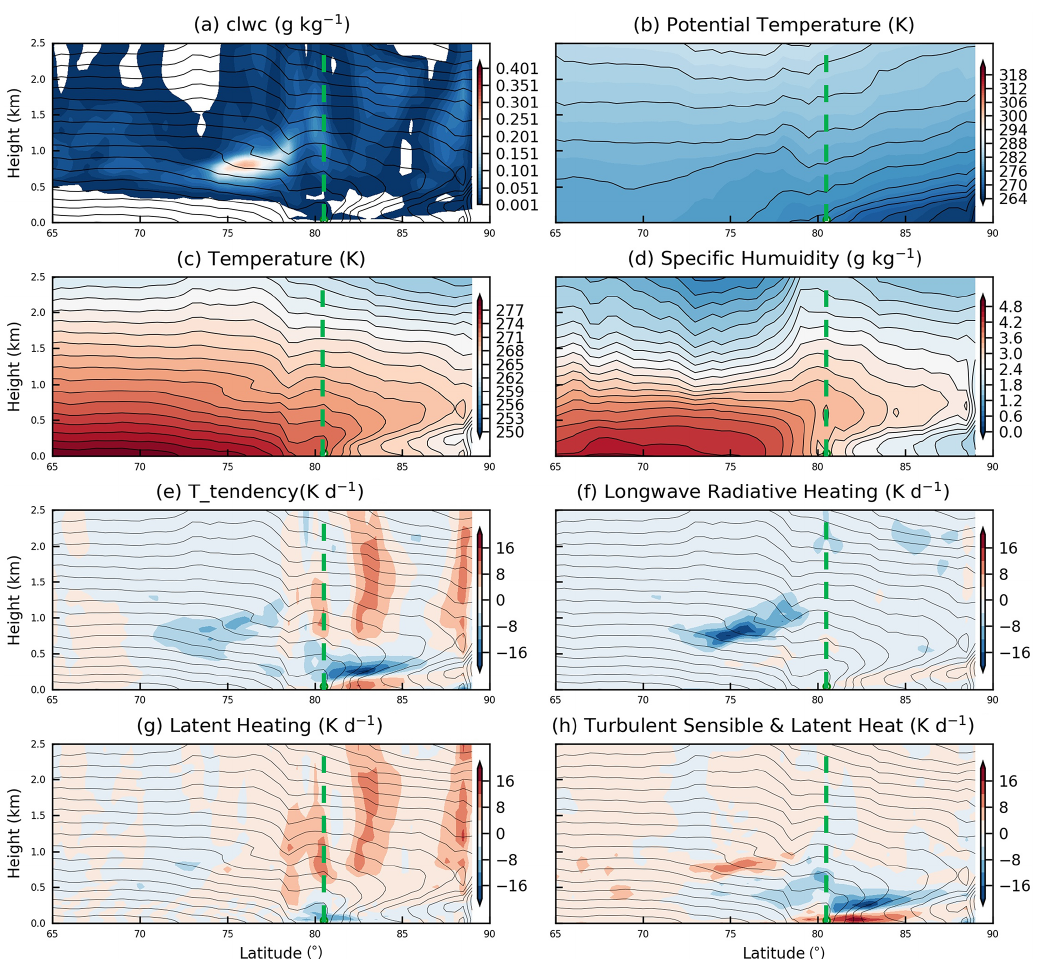
Figure 13. Same as Fig. 11 but for a selected turbulence-dominated WaMAI.